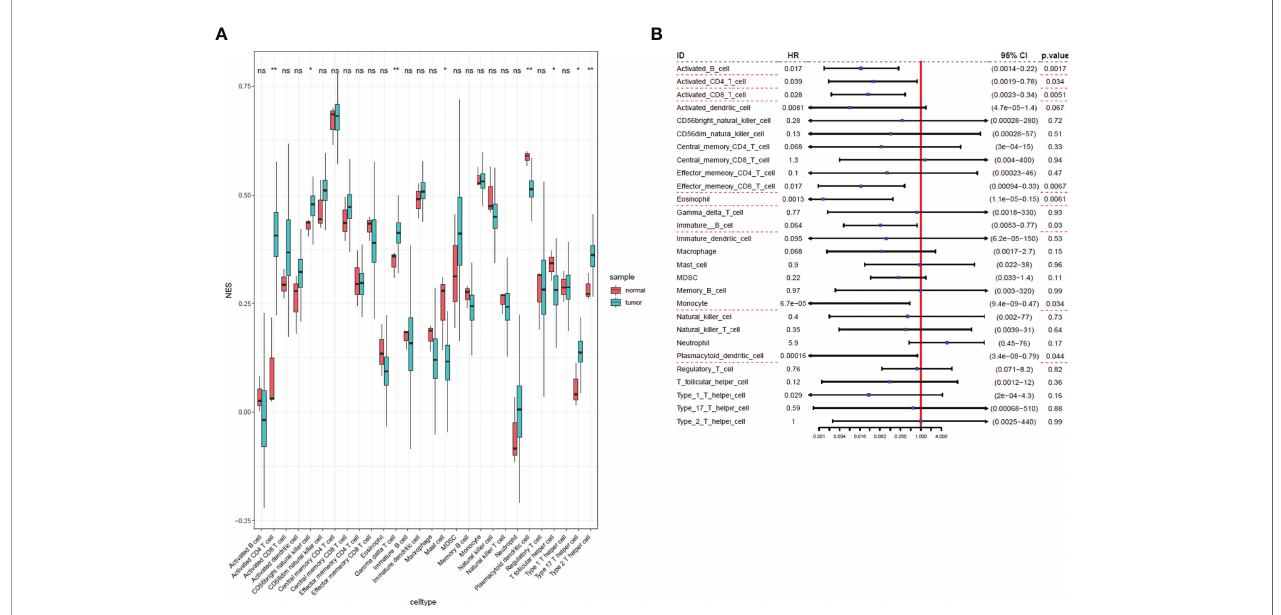
FIGURE 2 | Immunophenoscores and hazard ratios of 28 immune cells in cervical cancer. (A) Boxplot of immunophenoscores from 28 immune cells TCGA cervical cancer and normal samples. (B) Forest plot of hazard ratios in each in fi ltrated immune cell for OS. In fi ltrated immune cell subtypes signi fi cantly associated with overall survival were underlined with a red dashed line. *: P<0.05, **: P<0.01, ns, no signi fi cance.